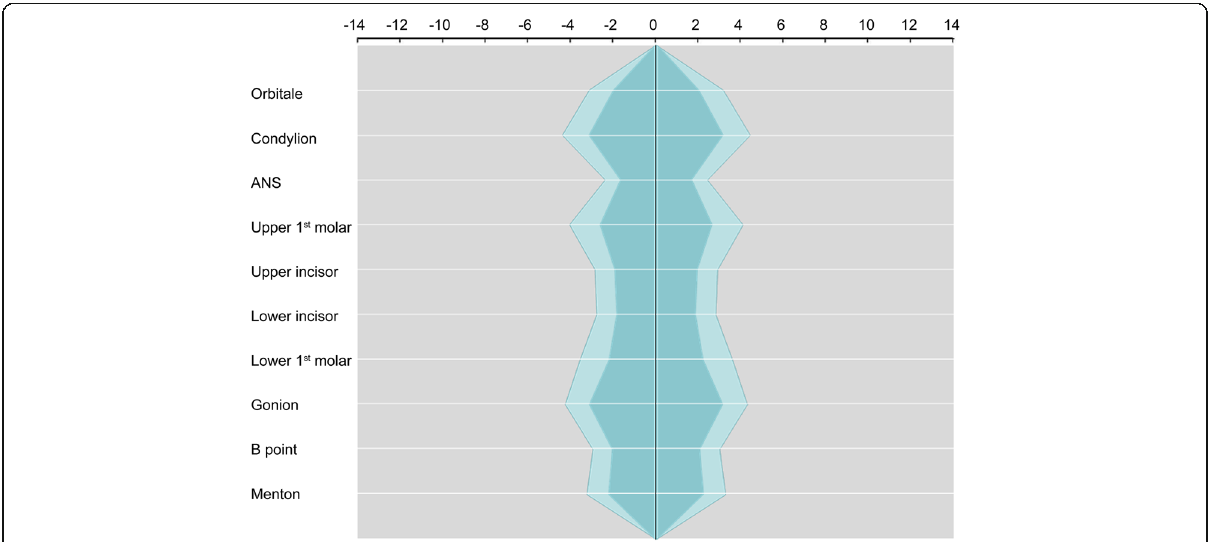
Fig. 5 Polygonal chart of the reference facial asymmetry index. The inner green area indicates the mean asymmetry indices and the outer light green area indicates the mean plus the standard deviation value ( p = 0.05). Right side deviation has a negative value, while left side deviation has a positive